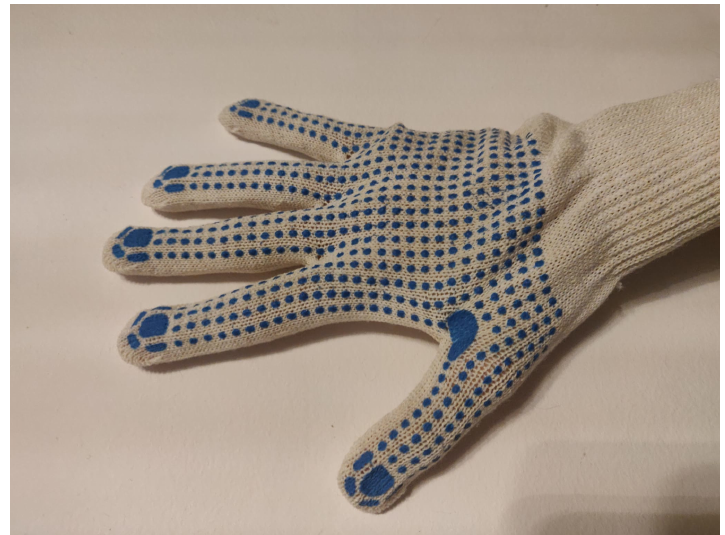
Figure 7. Glove in the hand without